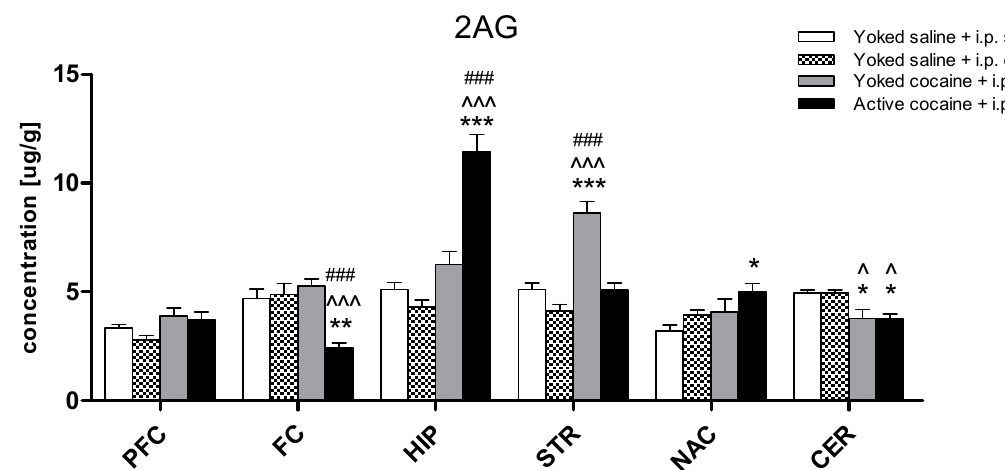
Figure 3. Levels of 2-arachidonoylglycerol (2-AG) in brain structures in rats previously self-administered cocaine (14 days) (Active cocaine) or which passively received cocaine (Yoked cocaine) or saline (Yoked saline) and underwent extinction training (10 days) and drug-induced reinstatement (10 mg/kg cocaine i.p. or saline i.p.). N = 7–8 rats/group. All data are expressed as the means ± SEM. * p < 0.05, ** p < 0.01, *** p < 0.001 vs. Yoked saline + saline i.p.; ^ p < 0.05, ^^ p < 0.01, ^^^ p < 0.001 vs. Yoked saline + cocaine i.p.; # p < 0.05, ## p < 0.01, ### p < 0.001 vs. Yoked cocaine + cocaine i.p. A description of the abbreviations has been placed under Figure 2.